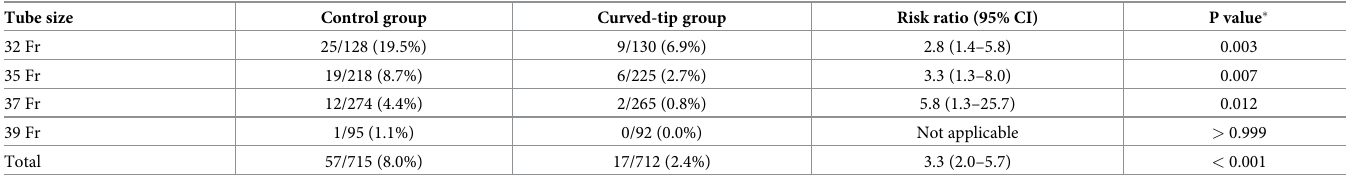
Table 2. Between-group comparisons of the incidence of the right bronchial misplacement in the use of left-sided double-lumen tubes of different sizes. Tube size